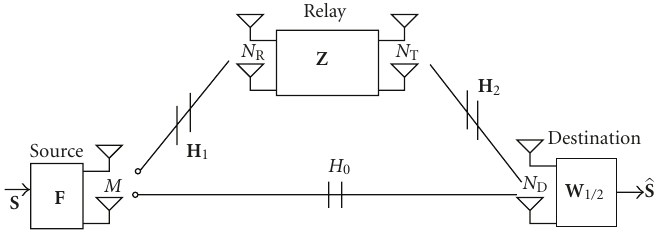
Figure 1: Cooperative MIMO relay